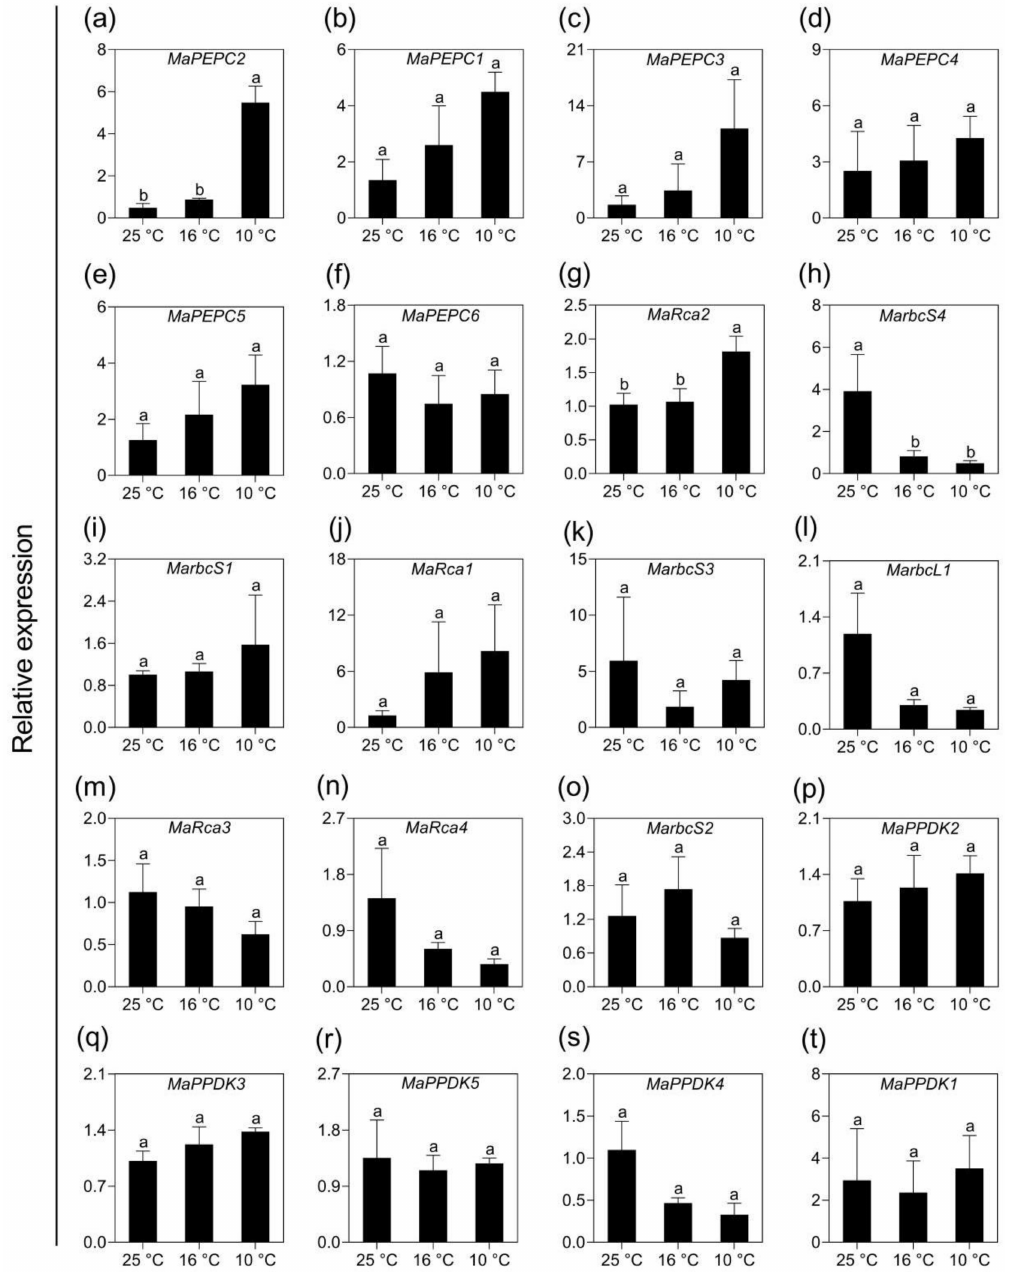
Figure 7. qPCR analysis of the expression of PEPC, Rubisco, and PPDK gene families in banana ( Musa spp. AAA) exposed to low temperatures. ( a – f ) Phosphoenolpyruvate carboxylase (PEPC) genes; ( g – o ) Rubisco genes; ( p – t ) Pyruvate, phosphate dikinase (PPDK) genes. Data are the average of three replicates ± standard error. Di ff erent letters above the columns represent significant di ff erence using Duncan’s multiple range test at p < 0.05 after angular transformation of the